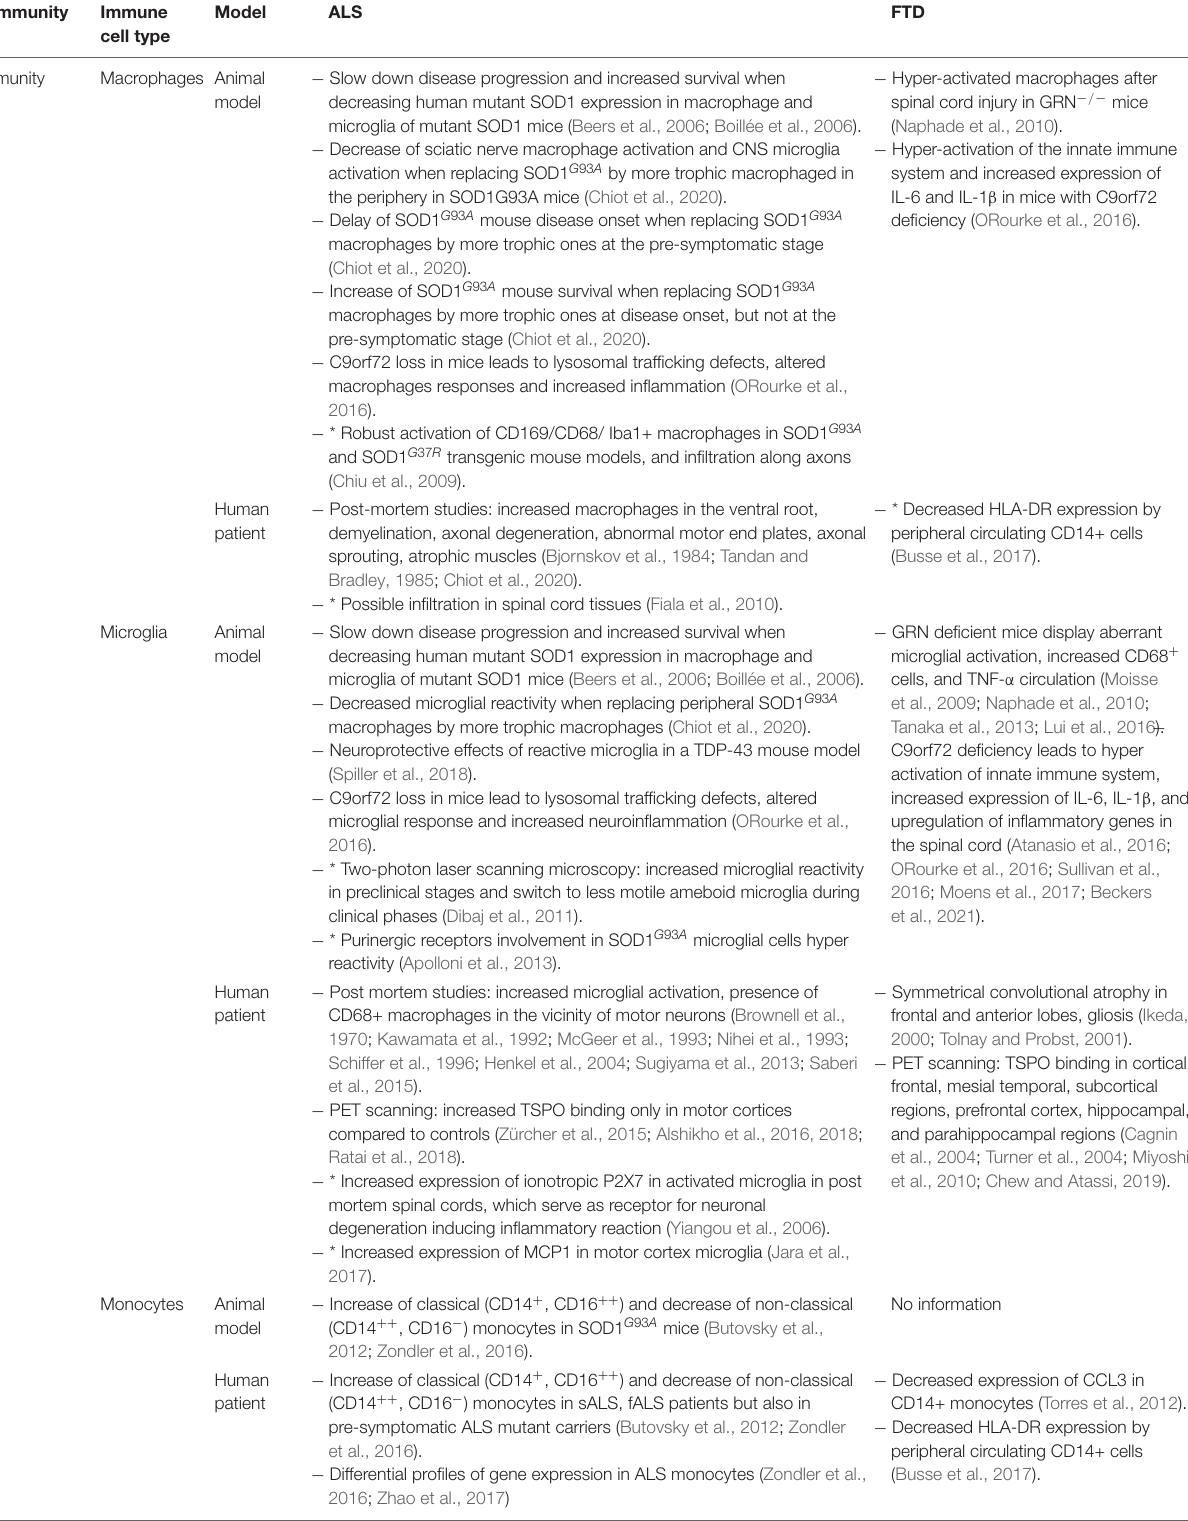
TABLE 3 | Publications studying immune cell involvement in ALS and FTD